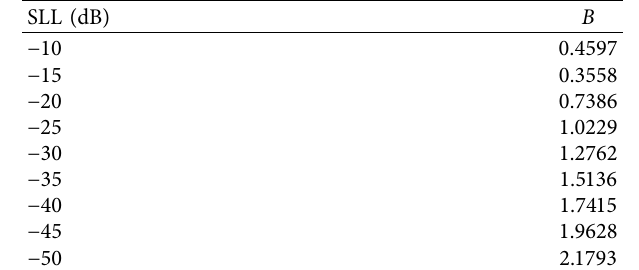
Figure 3: Proposed 9-element sparse array configuration based on Table